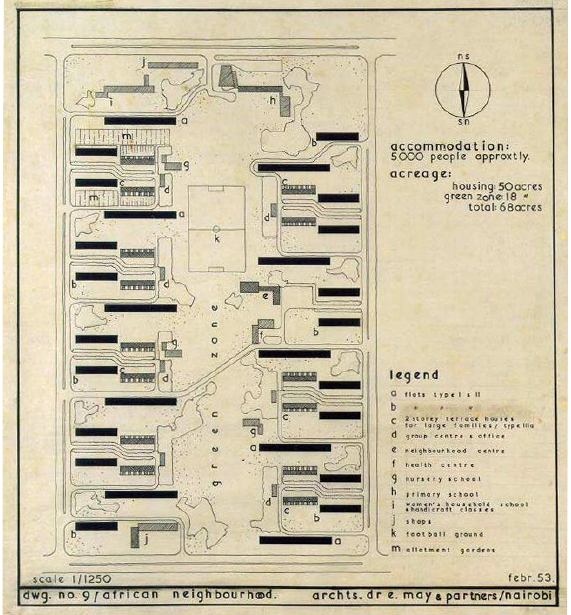
Figure 15. Port Tudor, African Neighbourhood. Source: Herrel (2001).